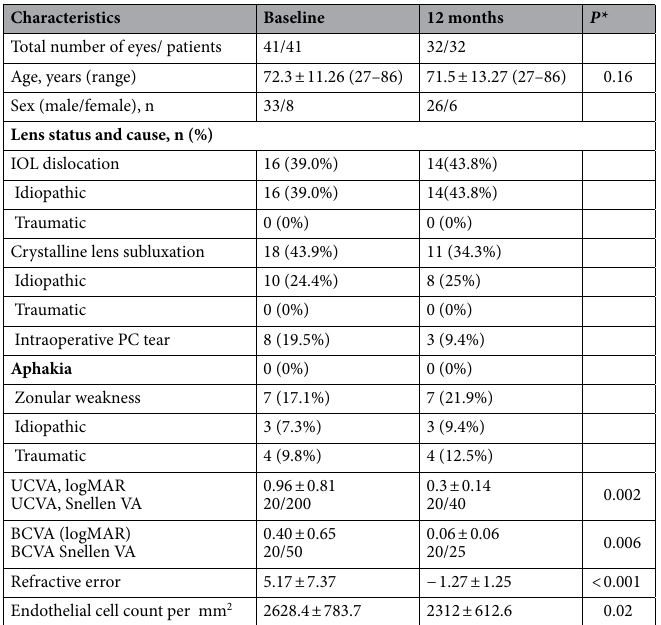
Table 1. Baseline characteristics and preoperative and postoperative clinical profiles of the patients included in this study. Data are presented as the mean ± standard deviation, n (%), or the range. * Independent t-test. BCVA, best-corrected visual acuity; IOL, intraocular lens; logMAR, logarithm of the minimum angle of resolution; PC, posterior capsule; UCVA, uncorrected visual